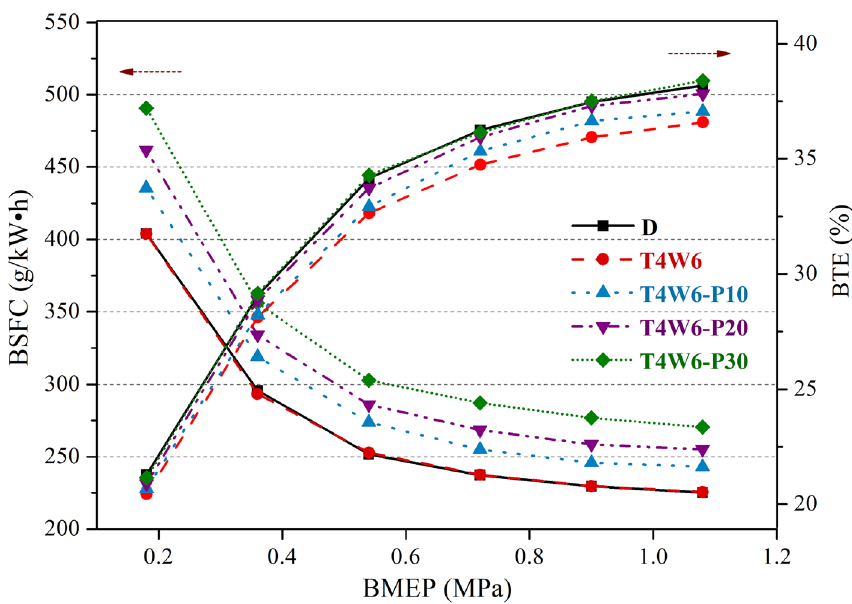
Figure 6. Effects of the PODEn blending ratio on the fuel economy of the diesel